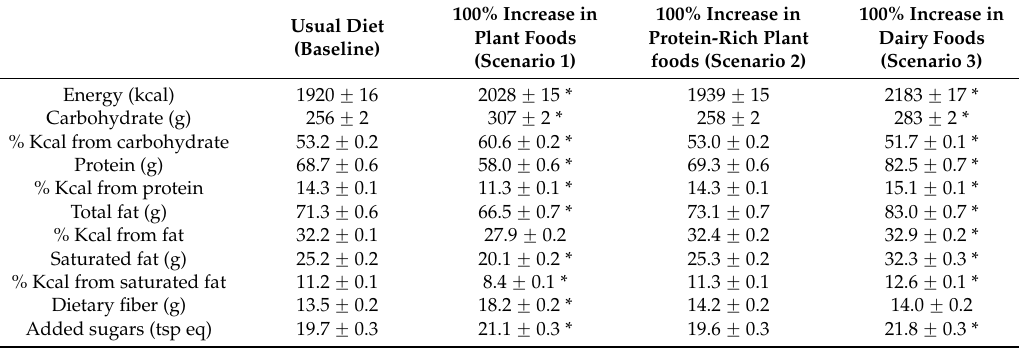
Table 3. Usual macronutrient intake in children, 2–18 years (NHANES 2007–2010) compared to a 100%